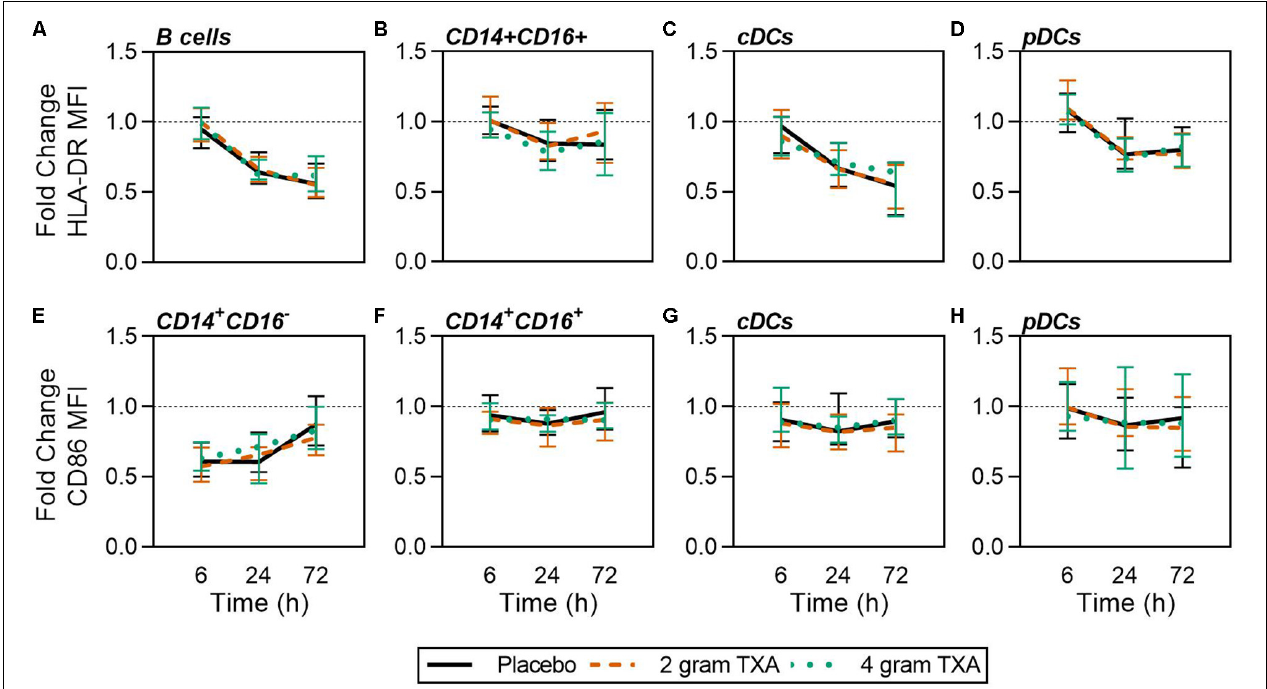
FIGURE 6 | Global reduction in HLA-DR and not CD86 expression in response to traumatic injury. For all kinetic data, fold change was calculated as [(frequency/MFI/concentration of a given population/analyte at the given time | | T6,T24,T72| |) ÷ (frequency/MFI/concentration of the same population/analyte at T0)]. Data are displayed as line graphs (fold change, median + IQR). The dashed line placed at y = 1 represents T0, or baseline. Placebo, n = 29; 2 g TXA, n = 24; 4 g TXA, n = 25. Statistical differences between the 4 g TXA and placebo groups at each given time point, as calculated via Kruskal–Wallis, are noted as follows: p > 0.05, not significant and not denoted on the graphical representation. Fold change in HLA-DR MFI on (A) B cells, (B) CD14 + CD16 + non-classical monocytes, (C) cDCs, and (D) pDCs over the 72 h study period. Fold change in CD86 MFI on (E) CD14 + CD16- monocytes, (F) CD14 + CD16 + non-classical monocytes, (G) cDCs, and (H) pDCs over the 72 h study